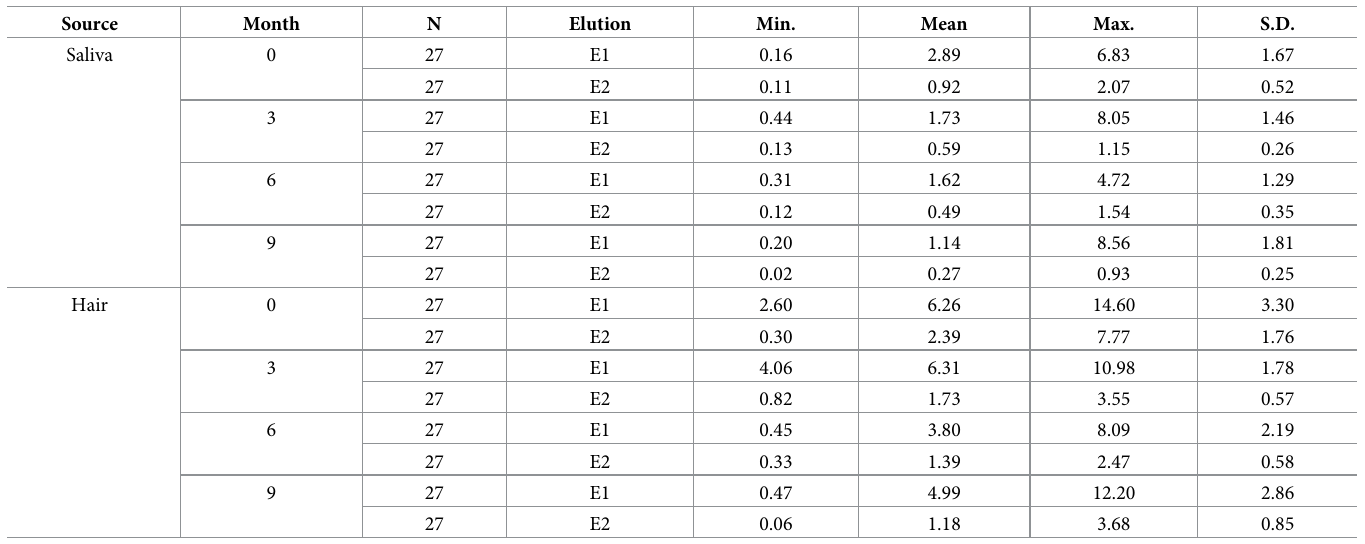
Table 2. Summary of DNA extracted from camel saliva and tail-hair samples over a nine-month